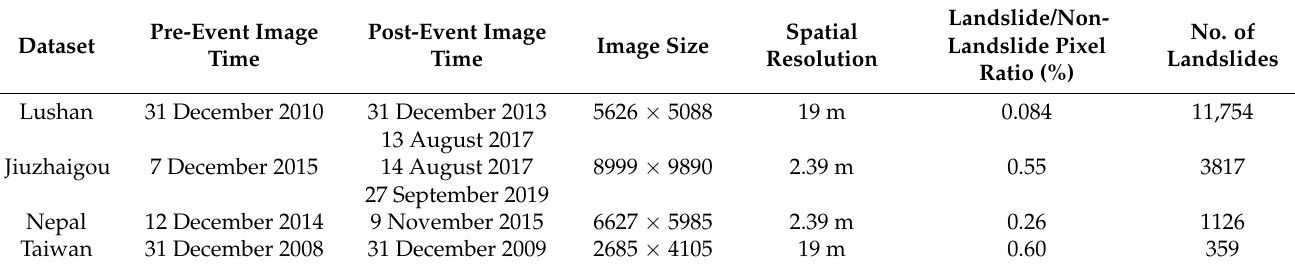
Table 1. General information of images used for each landslide